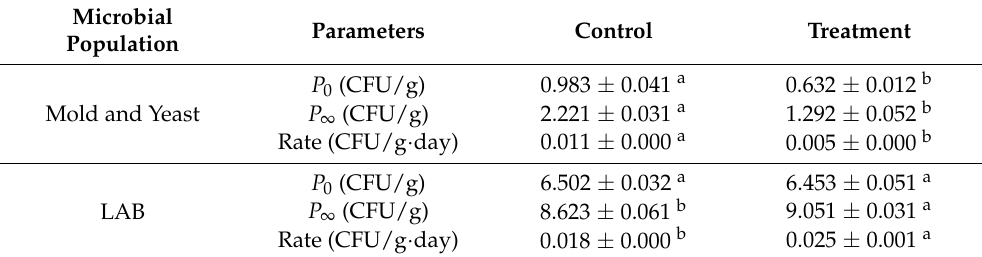
Table 9. Semicircular shape model parameters determined for the LAB counts vs. time and molds and yeast counts vs. time profiles of control and SBL-added cheeses. Microbial